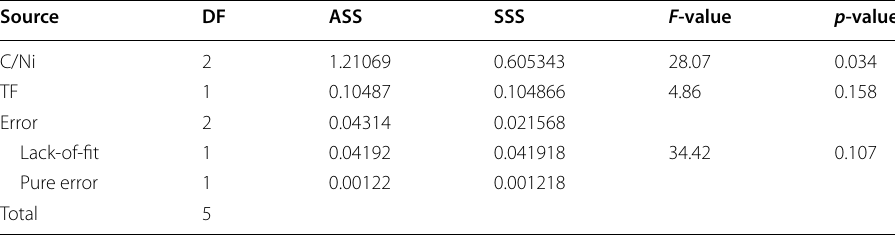
Table 15 ANOVA test associated with C/Ni and TF effects on CEC/OC Source